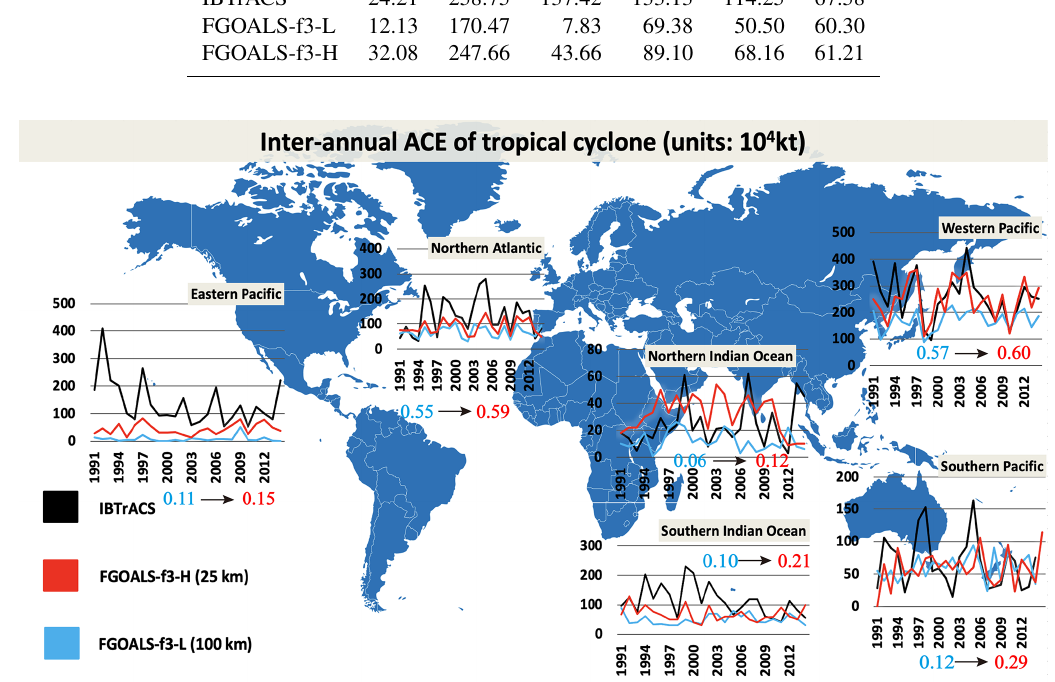
Figure 8. ACE of tropical cyclones (units: 10 4 kt) in the western Pacific, southern Pacific, northern Indian, northern Atlantic, eastern Pacific, and southern Indian oceans (units: number of cyclones) during the time period